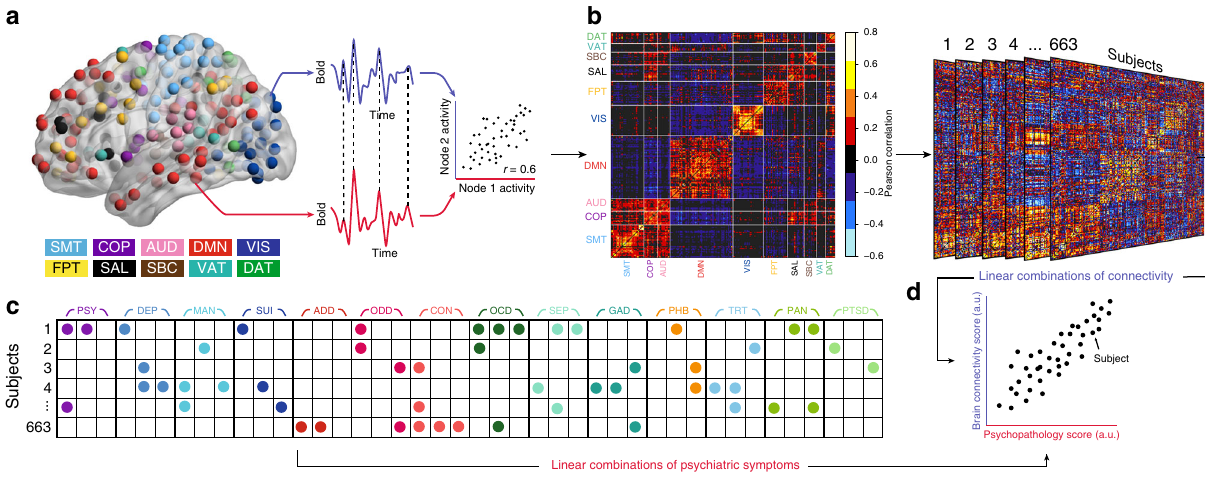
Fig. 2 Schematic of sparse canonical correlation analysis (sCCA). a Resting-state fMRI data analysis schematic and work fl ow. After preprocessing, blood- oxygen-level dependent (BOLD) signal time series were extracted from 264 spherical regions of interest distributed across the cortex and subcortical structures. Nodes of the same color belong to the same a priori community as de fi ned by Power et al. 10 . b A whole-brain, 264 × 264 functional connectivity matrix was constructed for each subject in the discovery sample ( n = 663 subjects). c Item-level data from a psychiatric screening interview (111 items, based on K-SADS 62 ) were entered into sCCA as clinical features (see details in Supplementary Data 1). d sCCA seeks linear combinations of connectivity and clinical symptoms that maximize their correlation. A priori community assignment: somatosensory/motor network (SMT), cingulo-opercular network (COP), auditory network (AUD), default mode network (DMN), visual network (VIS), fronto-parietal network (FPT), salience network (SAL), subcortical network (SBC), ventral attention network (VAT), dorsal attention network (DAT), Cerebellar and unsorted nodes not visualized. Psychopathology domains: psychotic and subthreshold symptoms (PSY), depression (DEP), mania (MAN), suicidality (SUI), attention-de fi cit hyperactivity disorder (ADD), oppositional de fi ant disorder (ODD), conduct disorder (CON), obsessive-compulsive disorder (OCD), separation anxiety (SEP), generalized anxiety disorder (GAD), speci fi c phobias (PHB), mental health treatment (TRT), panic disorder (PAN), post-traumatic stress disorder